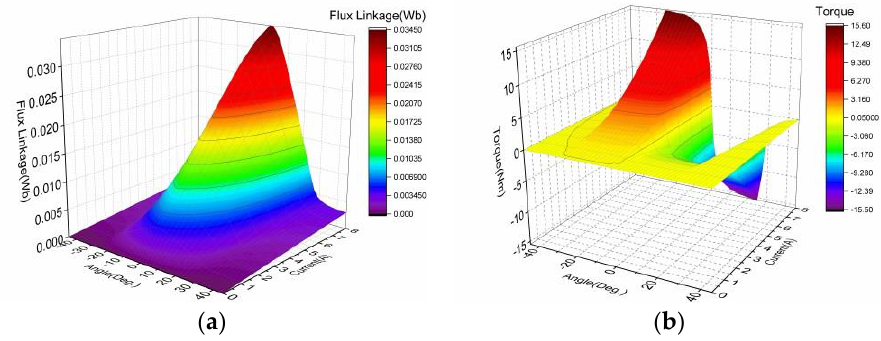
Figure 3. Linear interpolation results: ( a ) 3-D relationships of Ψ - i - θ ; ( b ) 3-D relationships of T - i - θ .